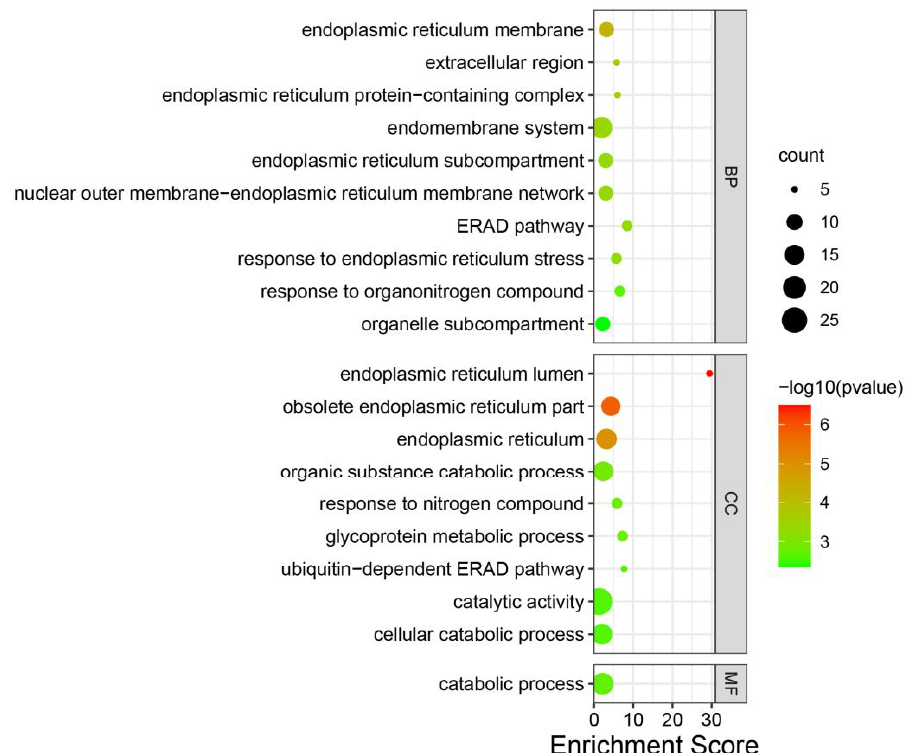
Figure 4. Enriched terms in MEpurple module identified by GO analysis. The columns and rows represent terms and enriched factors. The round size indicates the number of genes. BP, CC, and MF represent a biological process, cellular component, and biological process, respectively. A total of 20 GO terms were significantly enriched ( p < 0.005).